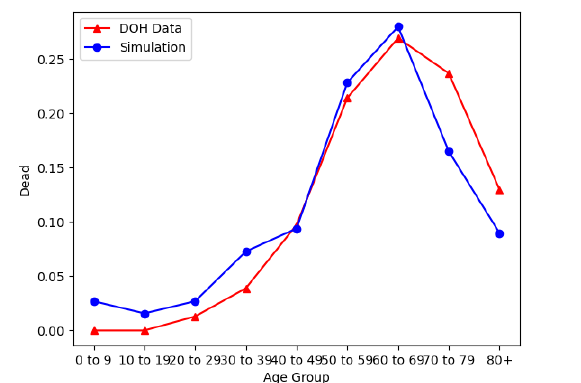
Figure 3. Validation of the death age distributions for the no vaccination